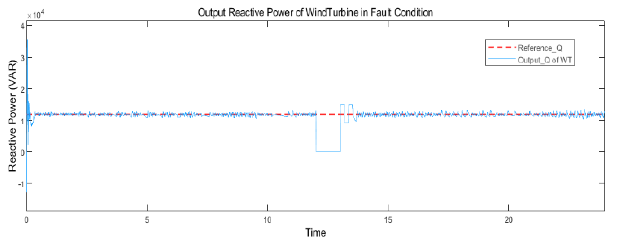
Fig. 13. Reactive output power of WT in the fault condition